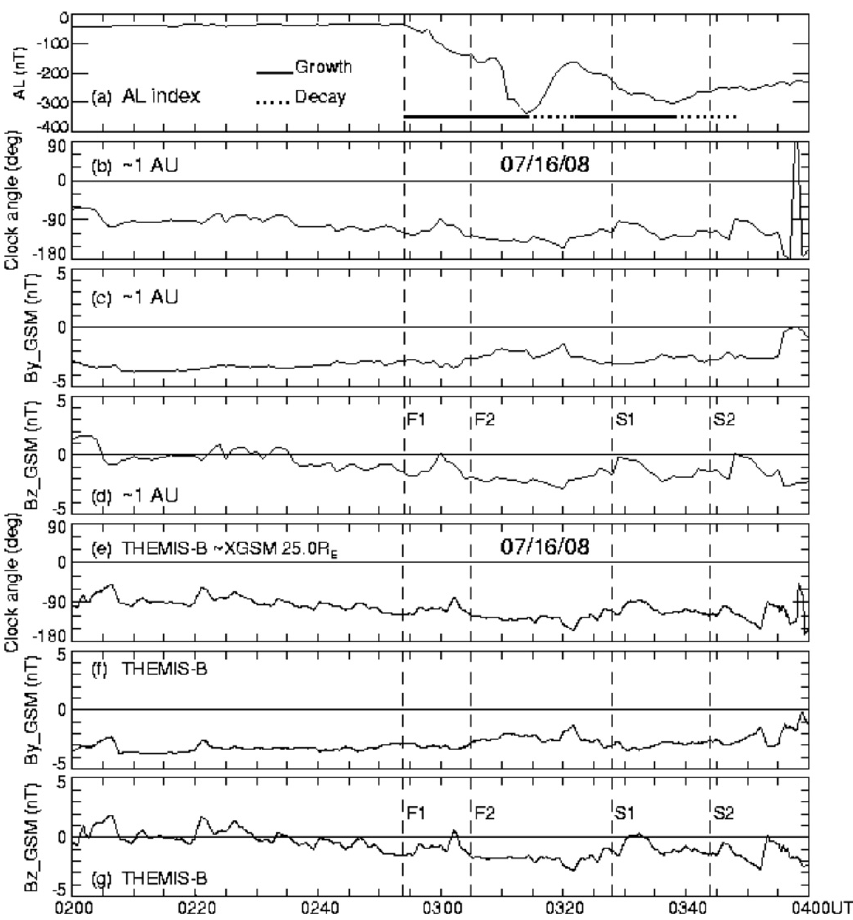
Fig. 14. The AL index, the IMF variations at ∼ 1AU (corresponding to XGSM ∼ 17.0 R E ) and THEMIS-B at XGSM ∼ 25.0 R E related to ground Pi2 onsets on 16 July 2008. The horizontal solid (dotted) line marks the time interval of growth (decay) in AL